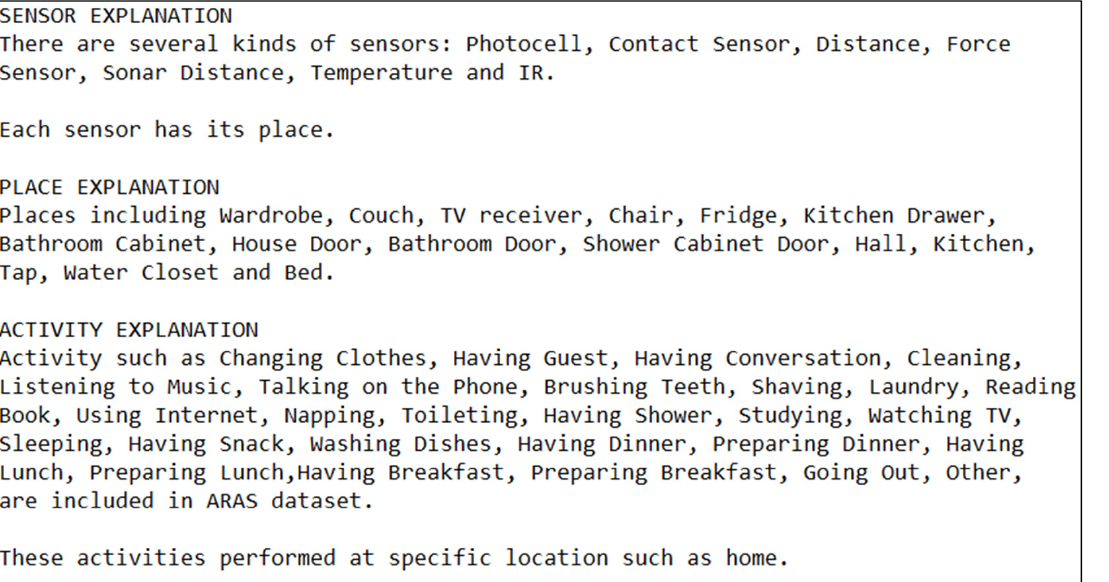
Figure 13. A sample fragment of the ARAS metadata.